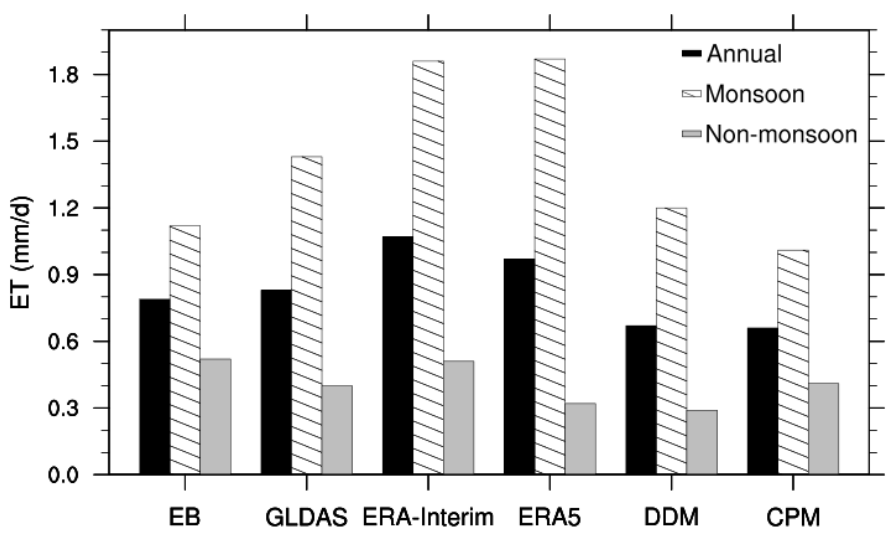
Figure 3. The annual and monsoon/non-monsoon seasonal mean ET in 2014 from the EB, GLDAS, ERA-Interim, ERA5, DDM, and CPM data averaged over the TP (units: mm/d). Table 3. The mean ET from the EB, GLDAS, ERA-Interim, ERA5, DDM, and CPM data, and the standard deviation (SD), the root-mean-square error (RMSE), and spatial correlation coefficients (CORR) of GLDAS, ERA-Interim, ERA5, DDM, and CPM compared to EB. ERA- EB GLDAS ERA5 DDM EB Interim